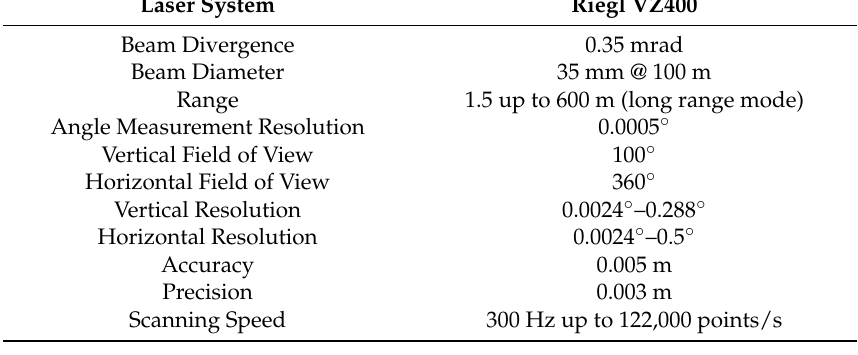
Table 1. Riegl VZ400 technical characteristics.